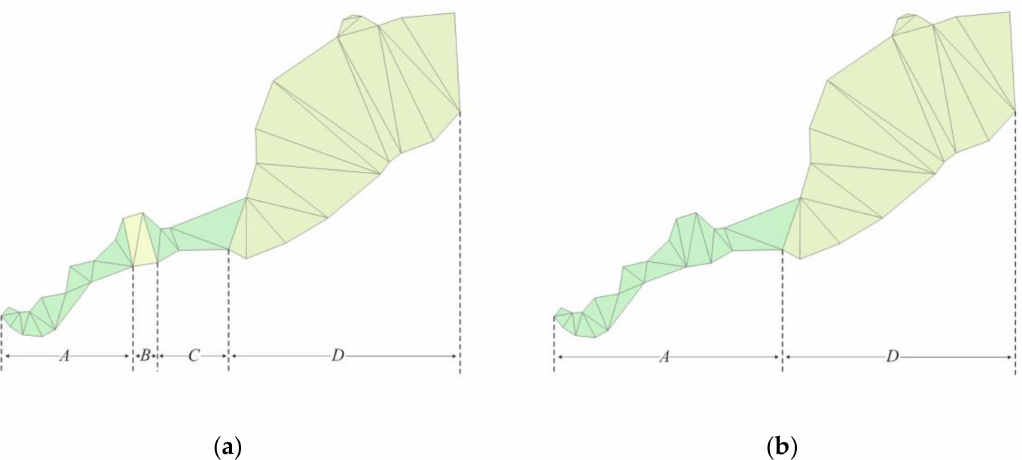
Figure 4. Segment extraction of a complex area. ( a ) Identification of segmented area. ( b ) Aggregation of segmented